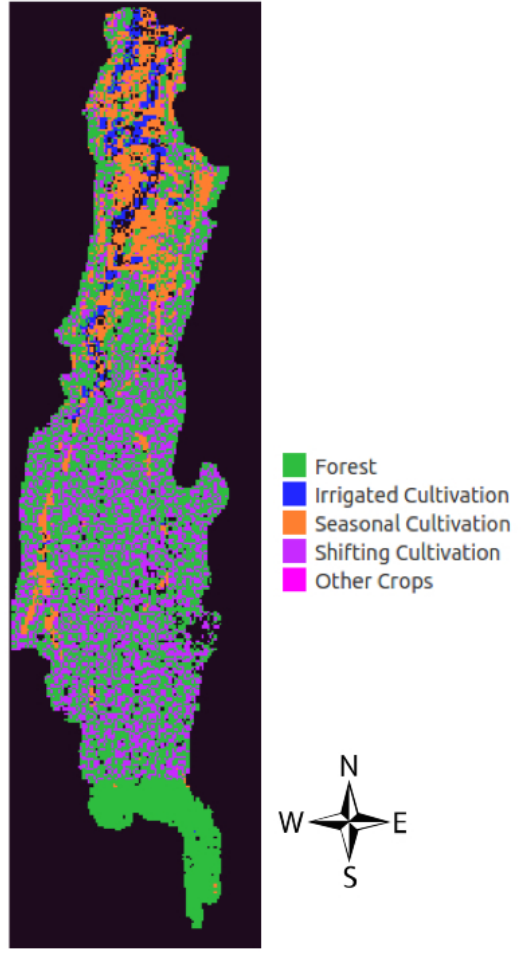
Figure 8. Land use map for 2035 when simulated with stopped growth of all settled agriculture scenario for the year 2035